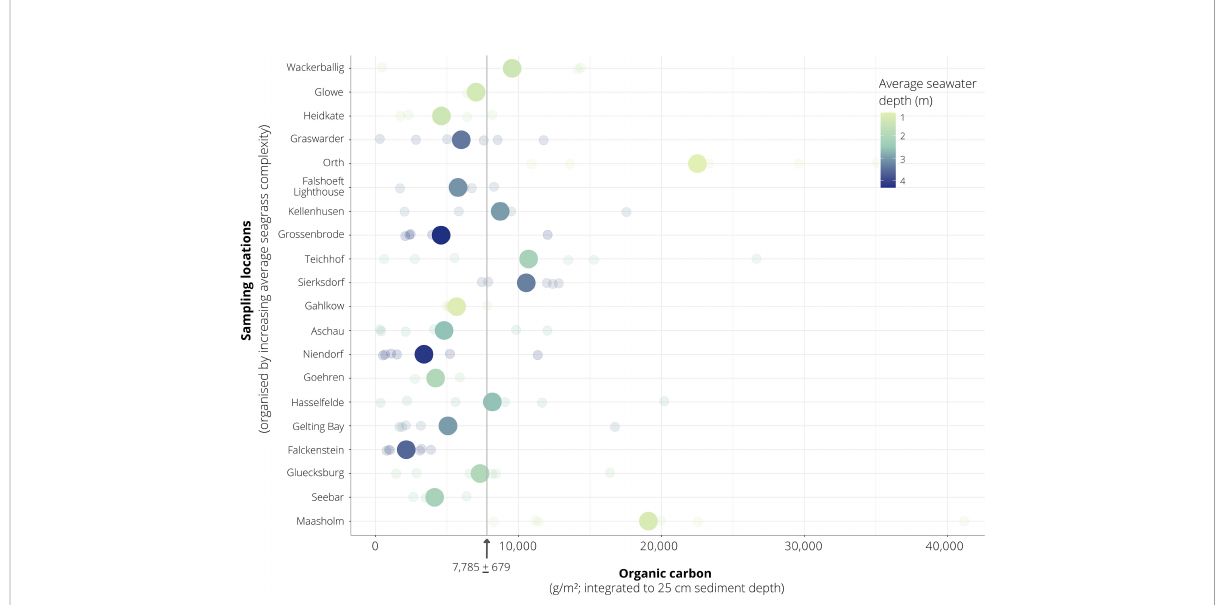
FIGURE 5 The interplay between seagrass complexity and seawater depth predictors of organic carbon (C org ) content in seagrass-vegetated sediments along the Baltic Sea coast of